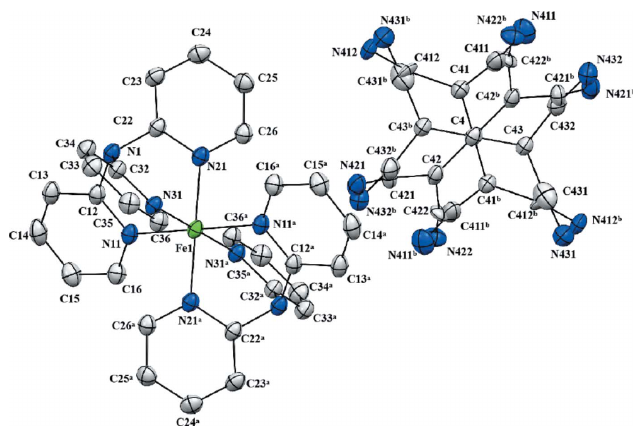
Figure 1 The structure of the two ionic components, showing the atom-labelling scheme. Displacement ellipsoids are drawn at the 30% probability level. The anion is disordered across a centre of inversion and the atoms marked ‘a 0 or ‘b 0 are at the symmetry positions (1 (cid:4) x , 1 (cid:4) y , 1 (cid:4) z ) and (1 (cid:4) x , 2 (cid:4) y , (cid:4) z ),